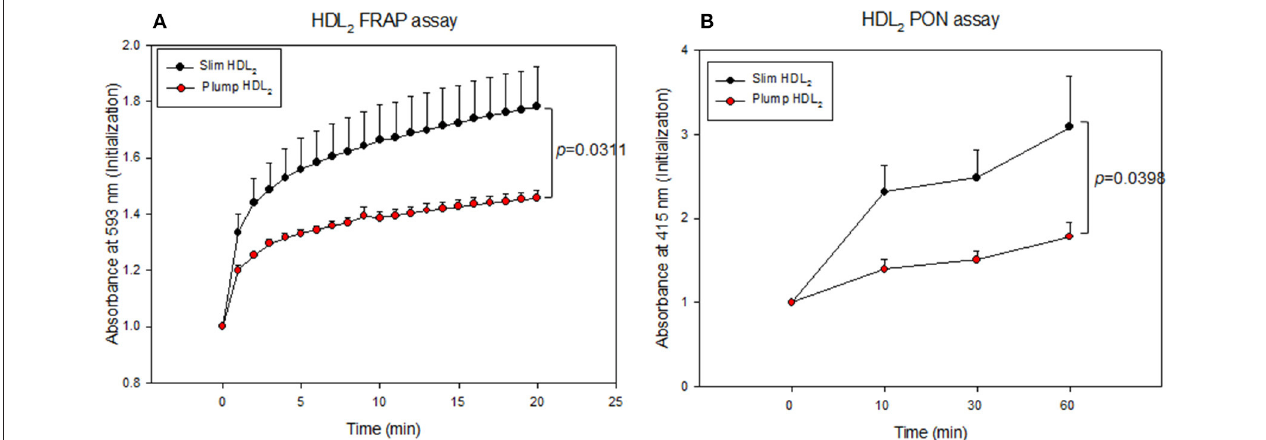
FIGURE 6 | Lipoprotein composition and glycation extent of slim and plump groups. Protein content (A) and glycation extent (B) . Lipoprotein composition and glycation extent of slim and plump groups. Cholesterol (C) and triglyceride content (D) .